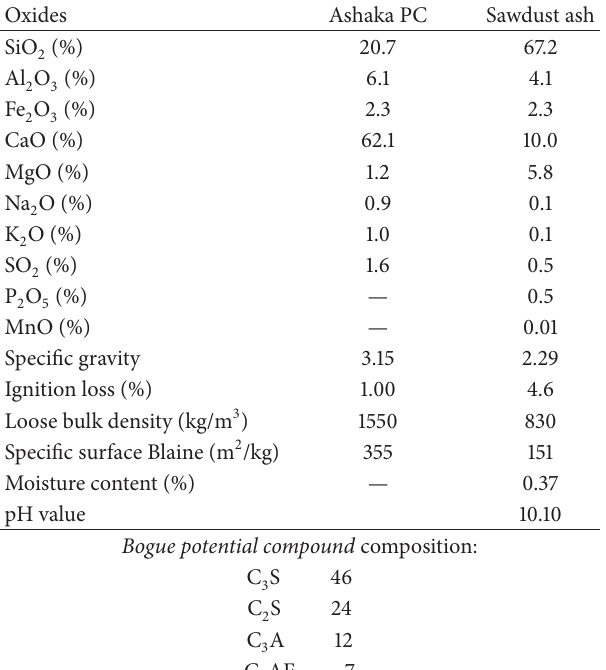
Table 1: Chemical and physical properties of OPC and SDA.